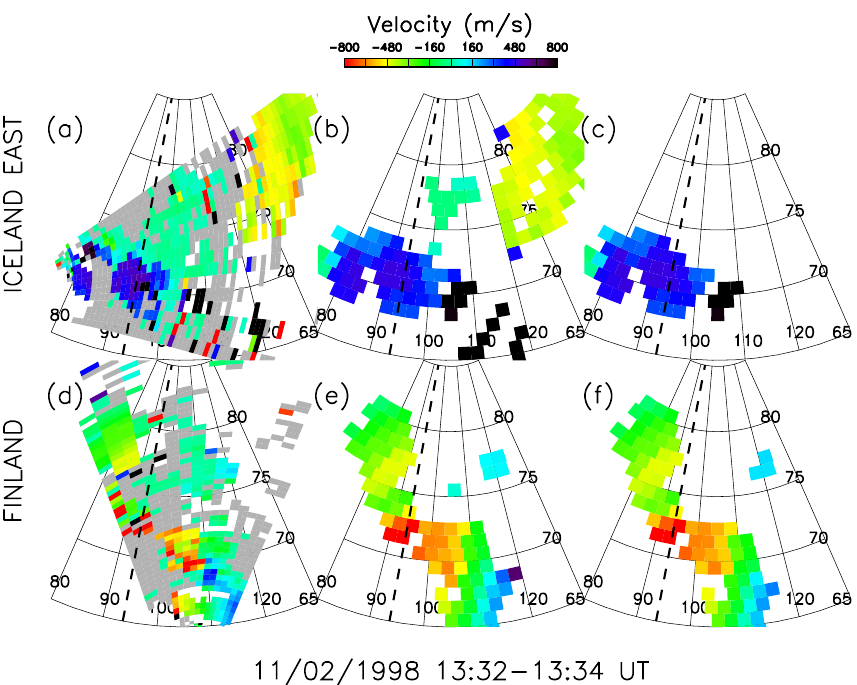
Fig. 13. Line-of-sight velocity map in geomagnetic coordinates for a single scan interval on 11 February 1998, (13:32–13:34 UT) for: (a) Iceland East - the grey region represents data identified as ground backscatter by the raw data processing. (b) Iceland East - gridded velocity data using default processing. (c) Iceland East - gridded velocity data using velocity-range gate filtering. (d) Finland - the grey region represents data identified as ground backscatter by the raw data processing. (e) Finland - gridded velocity data using default processing. (f) Finland - gridded velocity data using velocity-range gate filtering. The bold, dashed lines represent the location of